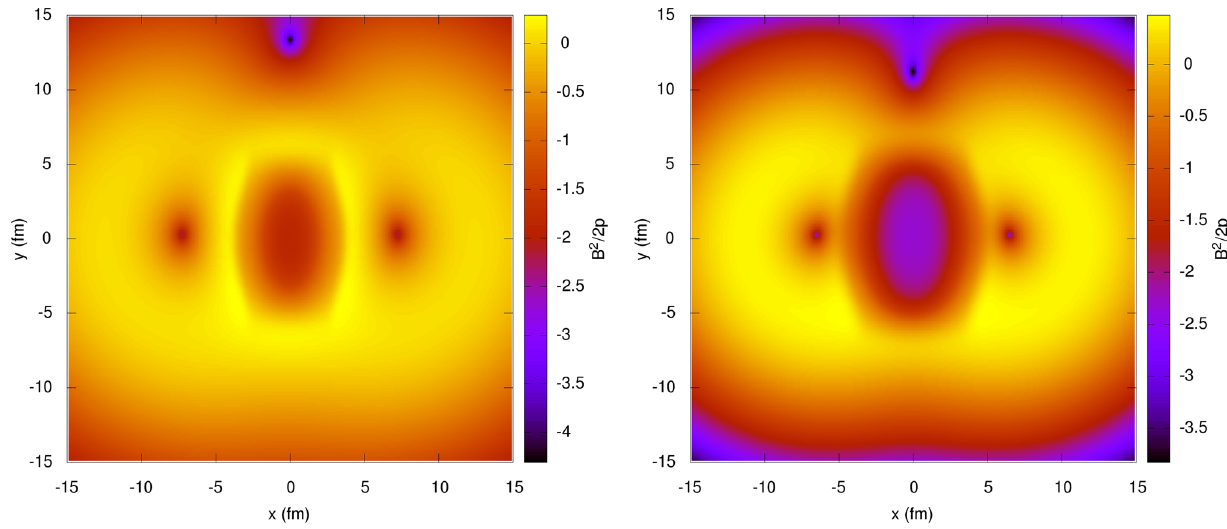
ter b = 12fm, the magnetic field is computed assuming a medium with √ s NN = 200GeV, constant electrical conductivity σ = 5 . 8MeV and a chiral magnetic √ s NN = 2 . 76TeV, conductivity σ χ = 1 . 5MeV